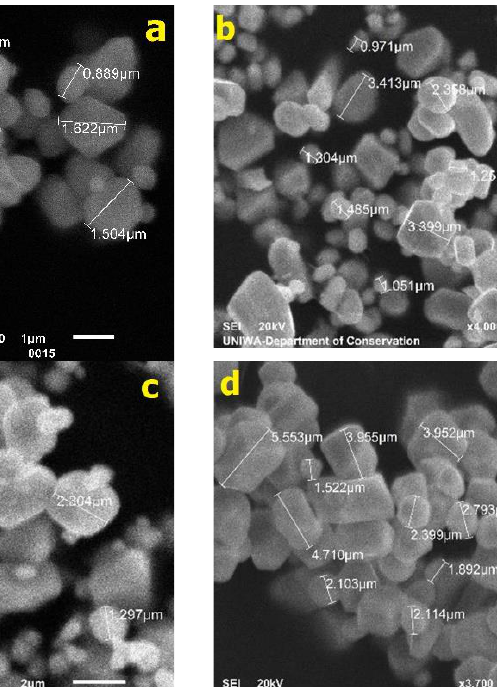
Table 1. Stoichiometric results for the examined grains.